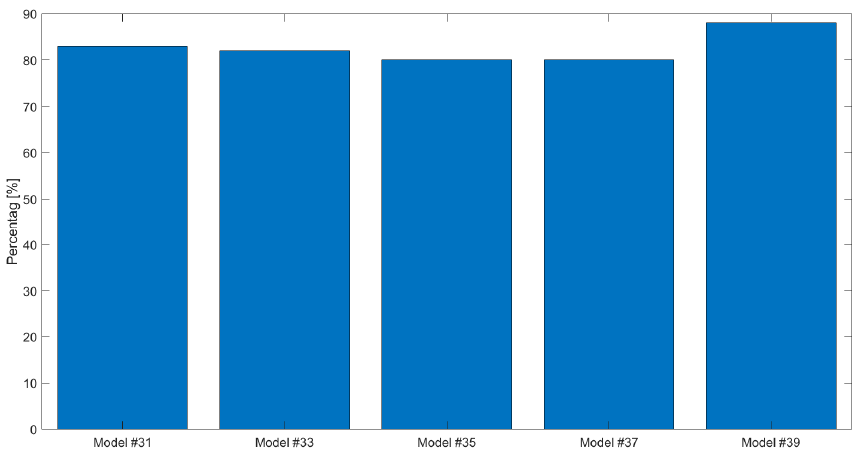
Figure 8. Percentage of the runs in which C-GPFM led to smaller average state errors than GPFM. Results for the models obtained on days #31, #33, #35, #37 and #39 for Case Study #1.